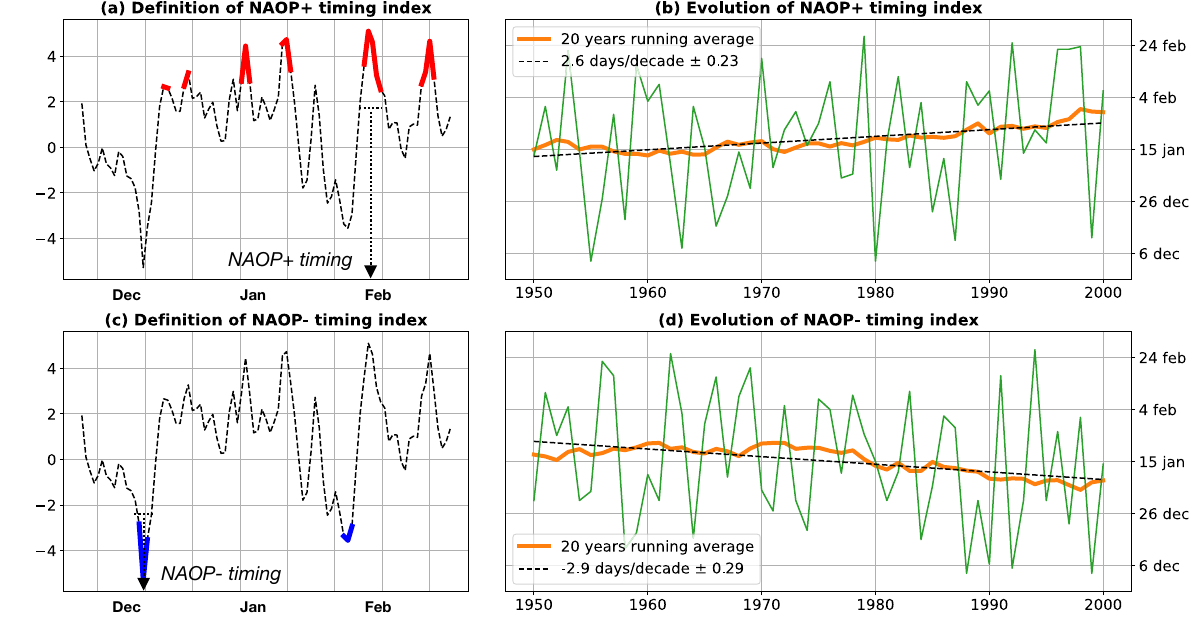
Figure 6. Definition of the ( a ) NAOP+ ( c ) NAOP− timing index. This index corresponds to the median date of the longest period of persistence of the daily NAO+ (NAO−) index over (under) a threshold. Evolution between 1950 and 2000 of ( b ) NAOP+ ( d ) NAOP− index. The linear trend (black dashed line) is 2.6 days/decade for NAOP+ between 1950 and 2000, and − 2.9 days/decade for